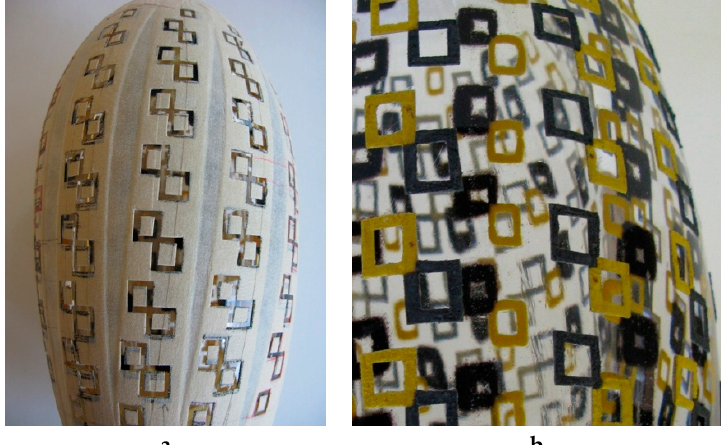
Figure 15. ‘ Square pattern ’ test 1 (2012). Cristalica glass body with Kugler glass powder: opaque yellow (K2078-Canary yellow) and opaque black (K2095-Opal black), 290 mm (H) × 175 mm (W), two layers of pattern.